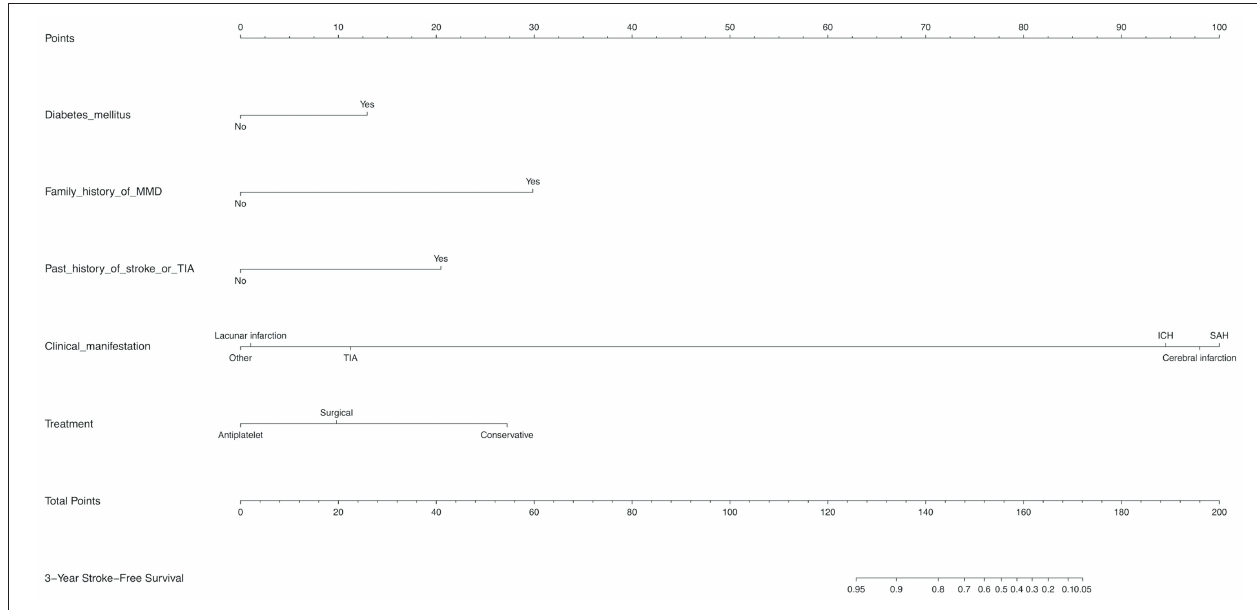
FIGURE 3 | Development of a novel nomogram for predicting the individual risk of future stroke among adult patients with moyamoya disease (MMD) via a multivariate Cox regression analysis. The predictive nomogram was developed in the training set, with diabetes mellitus, a family history of MMD, a past history of stroke or TIA, clinical manifestation, and treatment